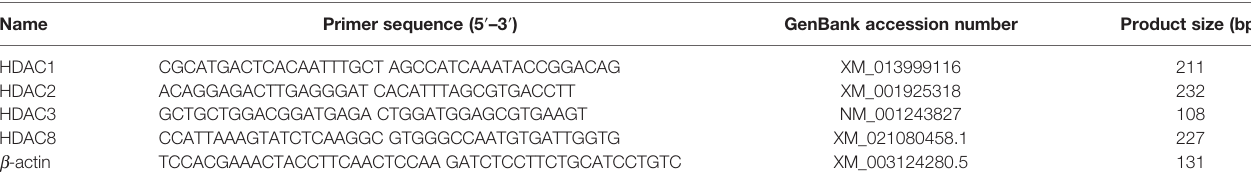
TABLE 1 | Primers used for